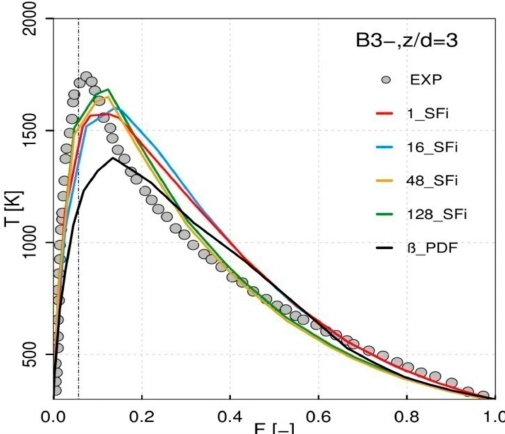
Figure 9. Mean Temperature from ESF/FPV simulation for different SFi at axial position z/d = 3 in comparison with Raman/Rayleigh data of B3 from [28].